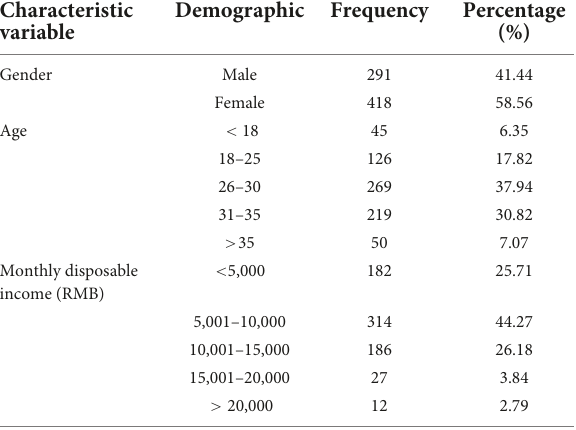
TABLE 2 Characteristics of social population structure.